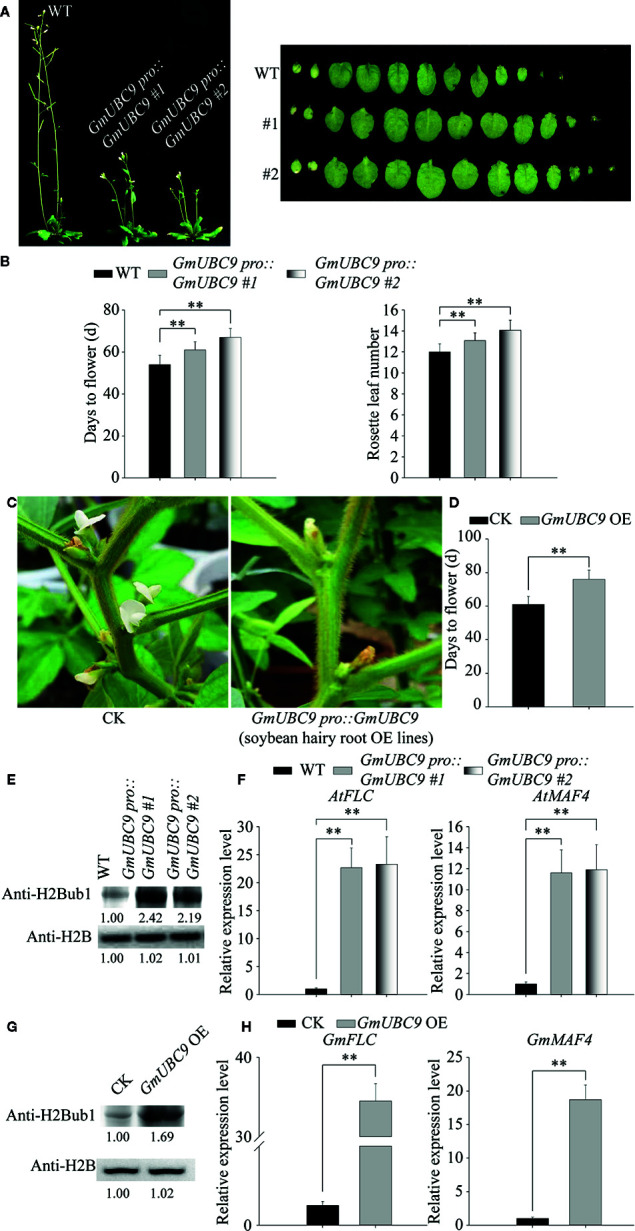
GmUBC9 inhibits plant flowering due to H2Bub1 and promotes the expression of FLC clade genes in Arabidopsis. (A) Flowering phenotypes and rosette leaves number of WT and GmUBC9-overexpressed Arabidopsis lines under normal growth conditions. (B) The number of rosettes and the number of days from germination until flowering. (C) Flowering phenotypes of WT and GmUBC9-overexpressing soybean hairy root lines under normal growth conditions. (D) The number of days it takes to bloom are counted. (E) Assessment of H2Bub1 in WT and GmUBC9-overexpressed Arabidopsis lines. The upper band was monoubiquitinated H2B, and the lower band was H2B. Values of band intensity relative to the first lanes from the left are indicated below the bands. (F) RT-qPCR analyses of the transcript levels of the floral repressor genes FLOWERING LOCUS C (FLC) and MADS ASSOCIATED FLOWERING 4 (MAF4). Data are normalized to WT, with AtACTIN as an internal control. Three biological replications were performed for each experiment. Data are means with standard deviations. (**P < 0.01; Student’s t-test). (G) The H2Bub1 level detected by western blot in WT and GmUBC9-overexpressed soybean hairy root lines. The H2B levels served as a loading control, with normalized band intensity values being shown. (H) RT-qPCR analyses of the transcript levels of the floral repressor genes FLC and MAF4 in soybean. Data are normalized to WT, with AtACTIN as an internal control. Three biological replications were performed for each experiment. Data are means with standard deviations from three independent biological replicates. (**P < 0.01; Student’s t-test).